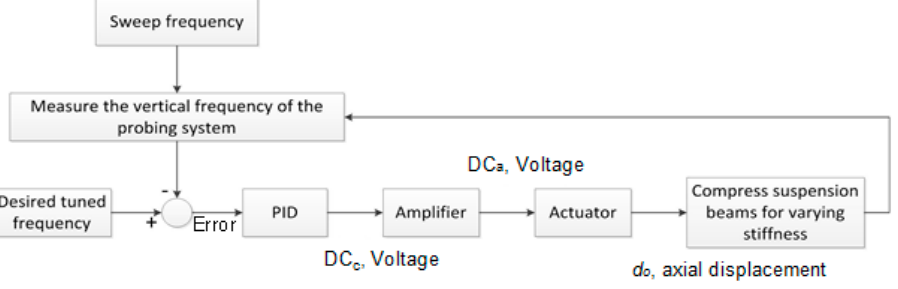
Figure 5. Block diagram of tuned stiffness for two modes (stiff and flexible). Note that DCc and DCa are the controlled voltage and amplified voltage, respectively. Table 1. Specification of the control system used to tune the frequency in both modes.